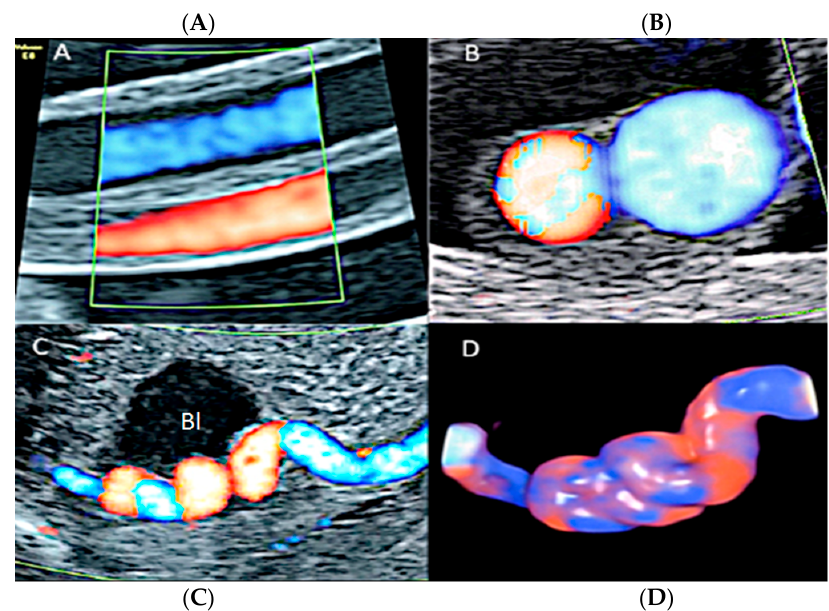
Figure 31. Pregnancy at 22 week’s gestation. Color Doppler ( A–C ) and four-dimensional STIC with color Doppler ultrasound in “glass-body” mode ( D ). Longitudinal and axial scan of the cord ( A–C ) demonstrate the presence of a single umbilical artery (SUA). SUA shows a particular paravesical kinking (Bl: bladder).